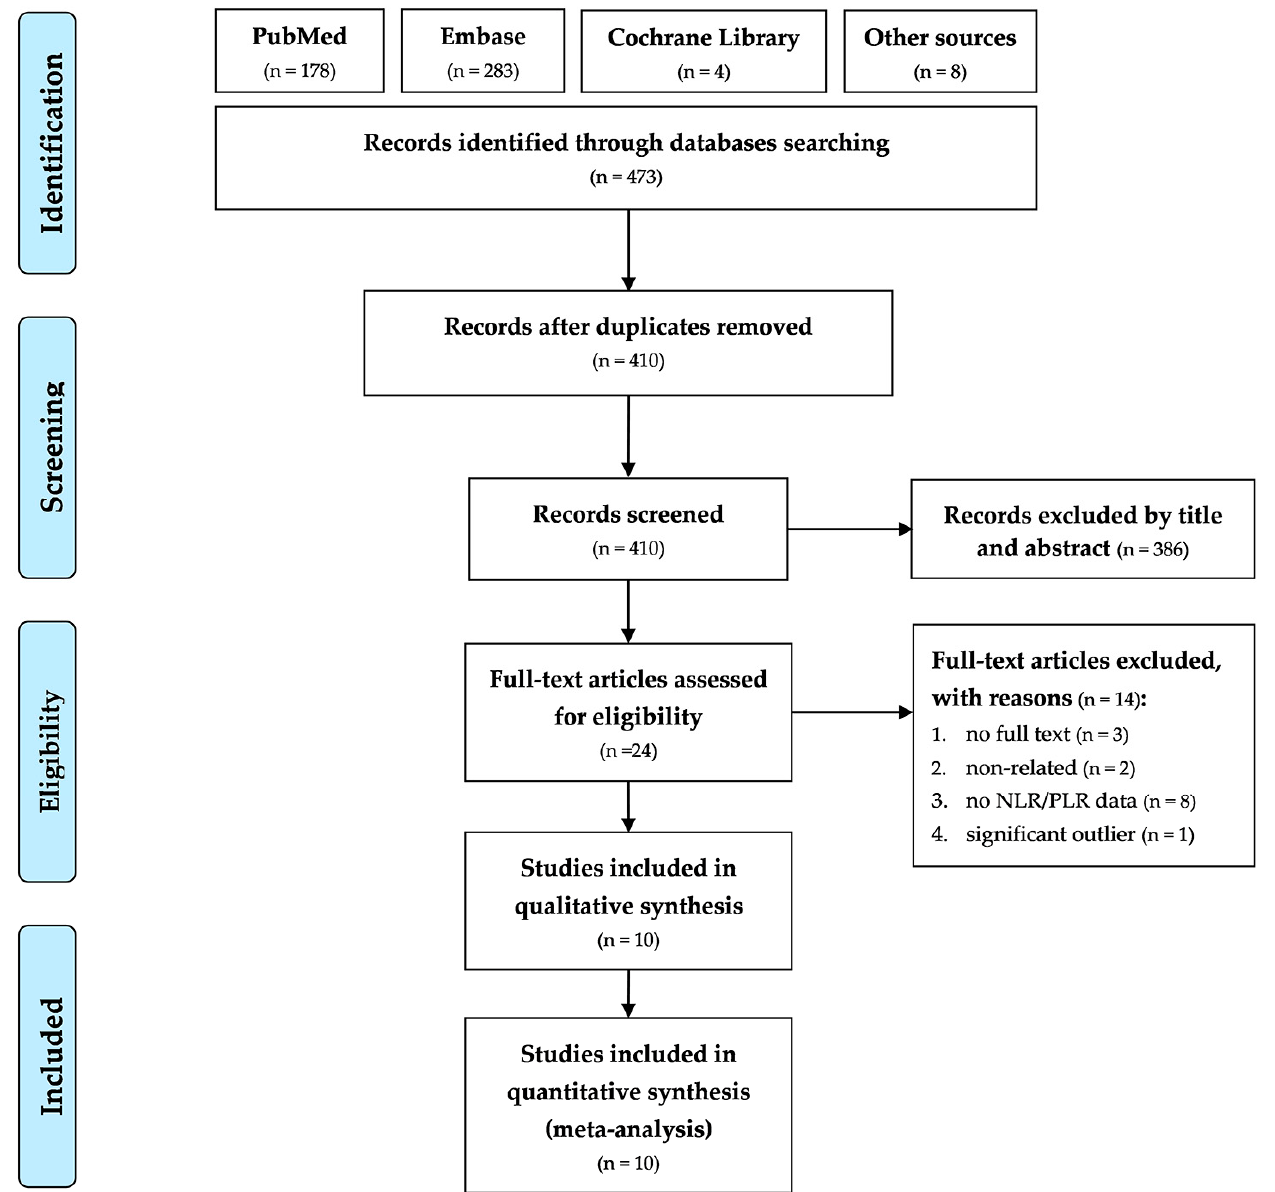
Figure 1. PRISMA flowchart of the selection of included studies.